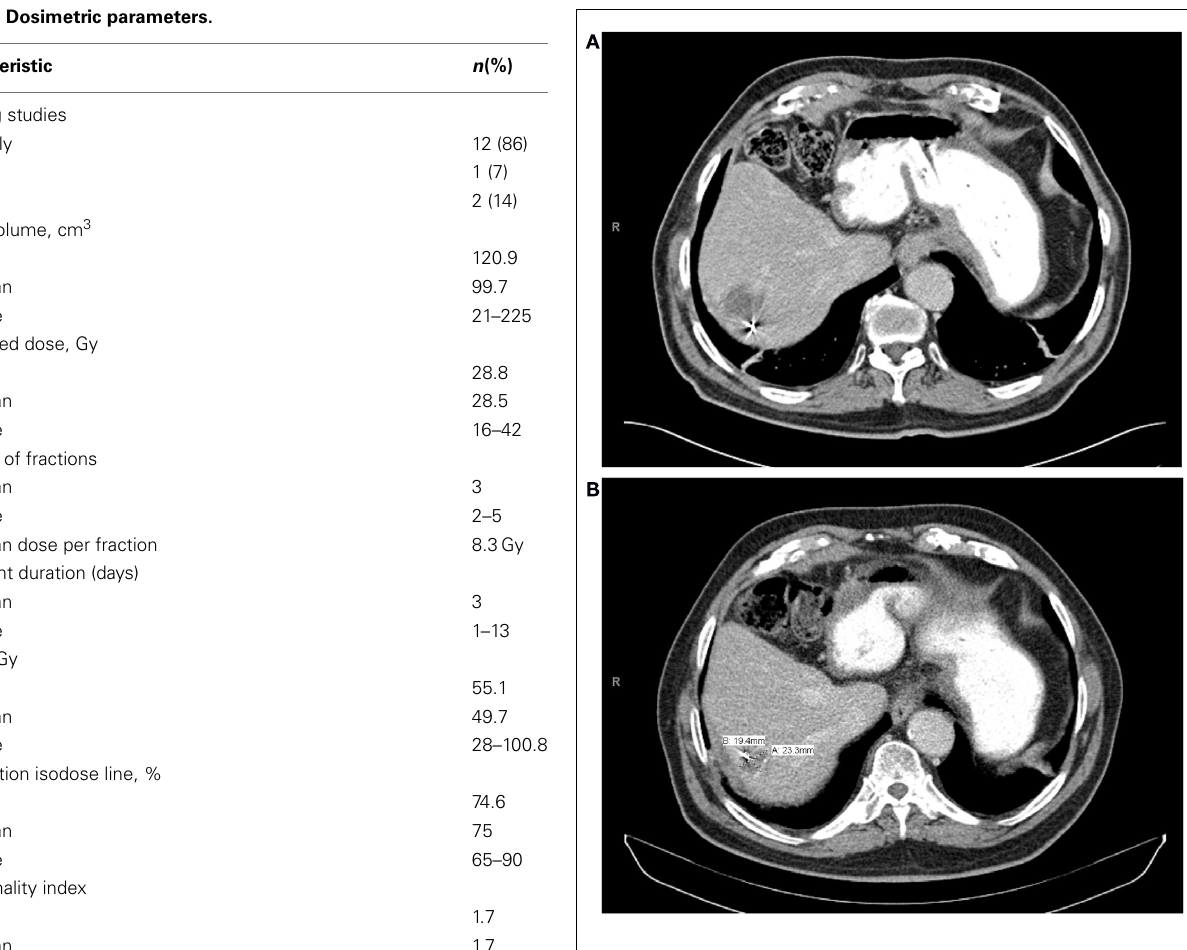
FIGURE 4 | (A) One month post-treatment CT scan, (B) 10month post-treatment CT